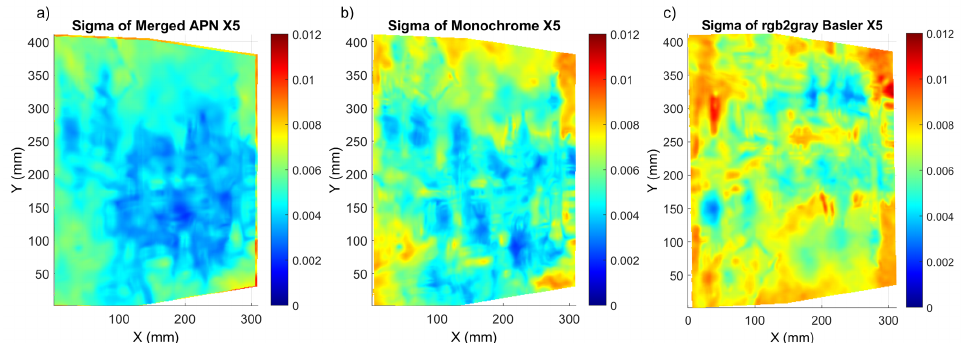
Figure 7. Sigma distribution for the Street painting corresponding to shift X5 for the ( a ) merged APN, ( b ) Monochrome and ( c ) rgb2gray Basler methods